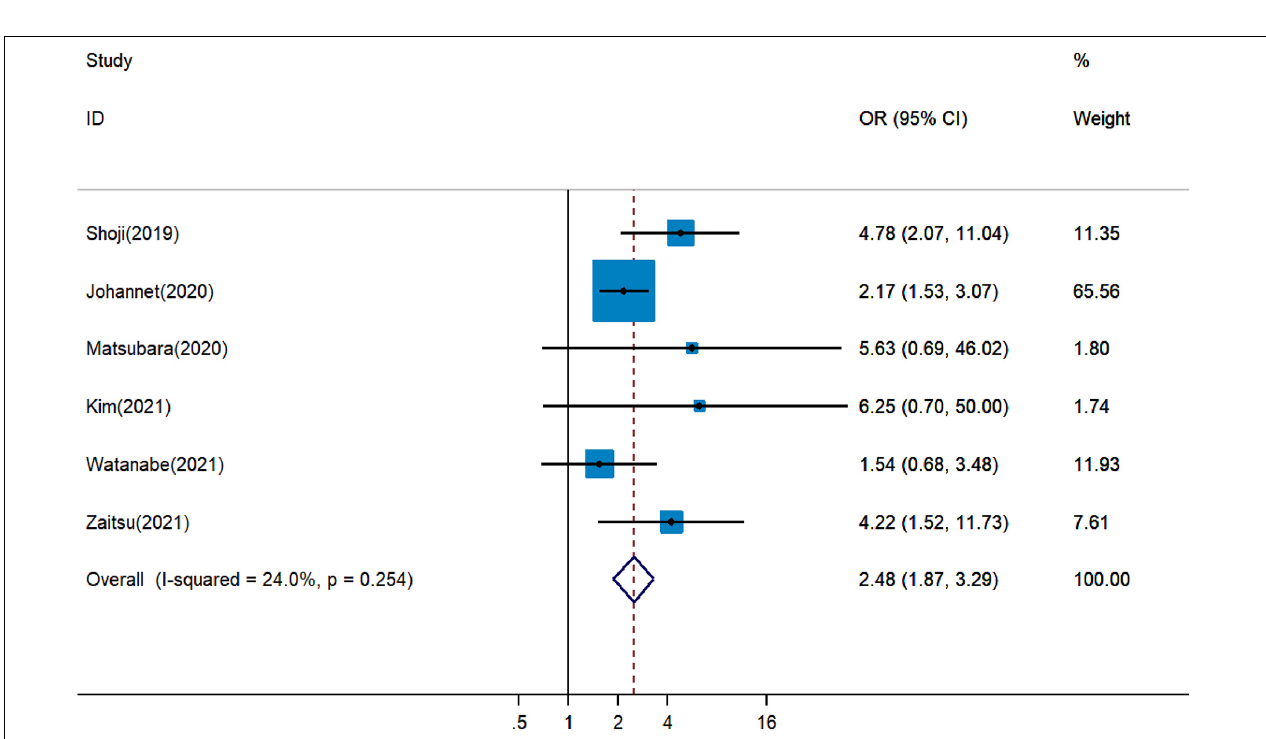
Frontiers in Nutrition |